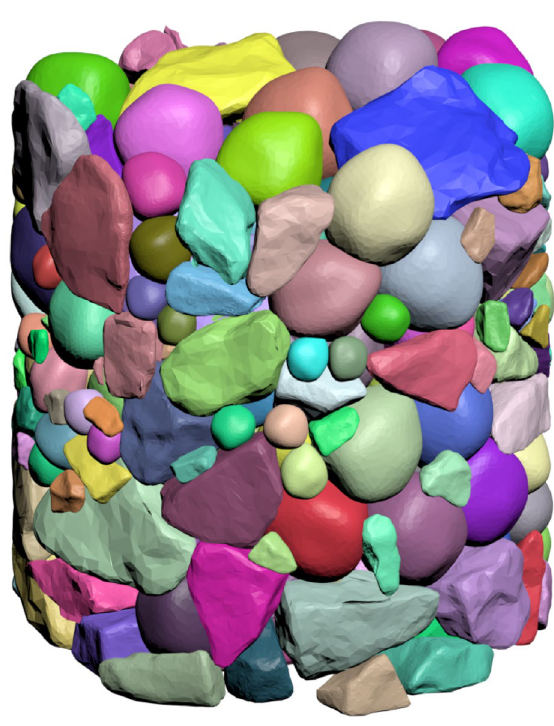
Fig. 3 Identification of individual particles by improved watershed